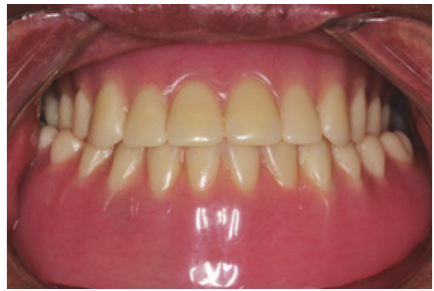
Figure 11: Final prosthesis in the